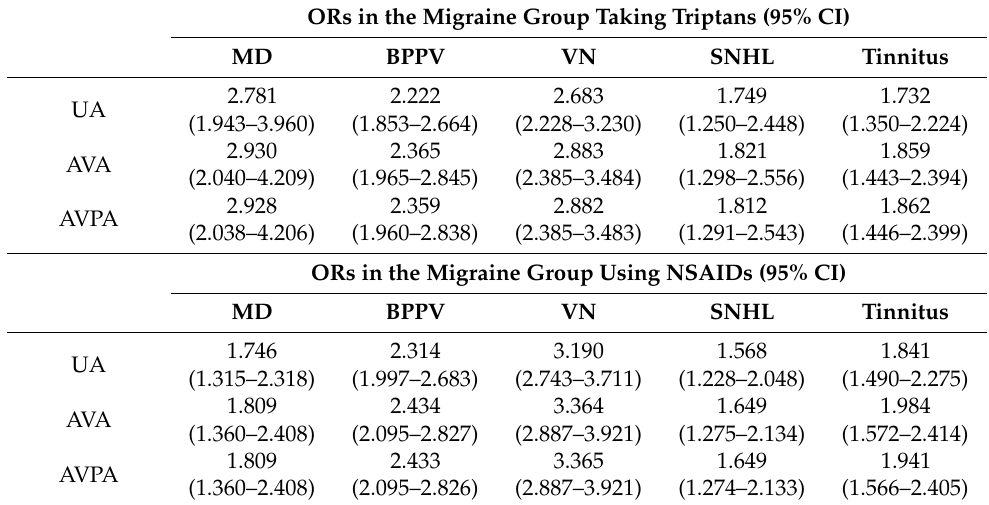
Table 4. ORs for vestibular and cochlear disorders in migraine subgroups after PSM.